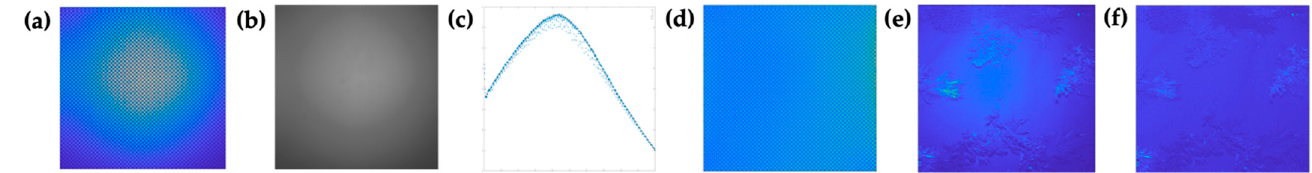
Figure 4. Illumination falloff correction procedure for 1000 by 1000 pixel images (except ( e , f ), which are subset of 650 by 650 pixels, centered on image), showing ( a ) background checkerboard; ( b ) intensity averaged background (i.e., Gaussian filter—10 pixel radius); ( c ) curve-fitting pixel intensity profile at center of illumination; ( d ) original checkerboard background corrected for illumi- nation falloff; ( e ) uncorrected raw image with noticeable light intensity falloff; ( f ) illumination falloff corrected image where background is mostly uniformized in its intensity.